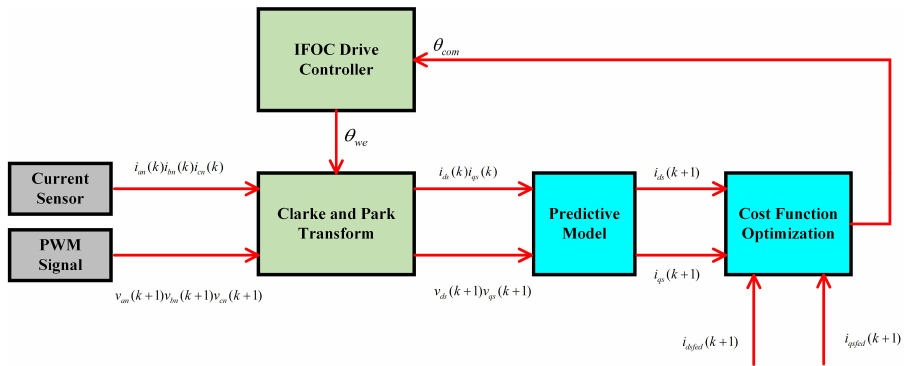
Figure 2. Control diagram of model-based predictive rotor field-oriented angle